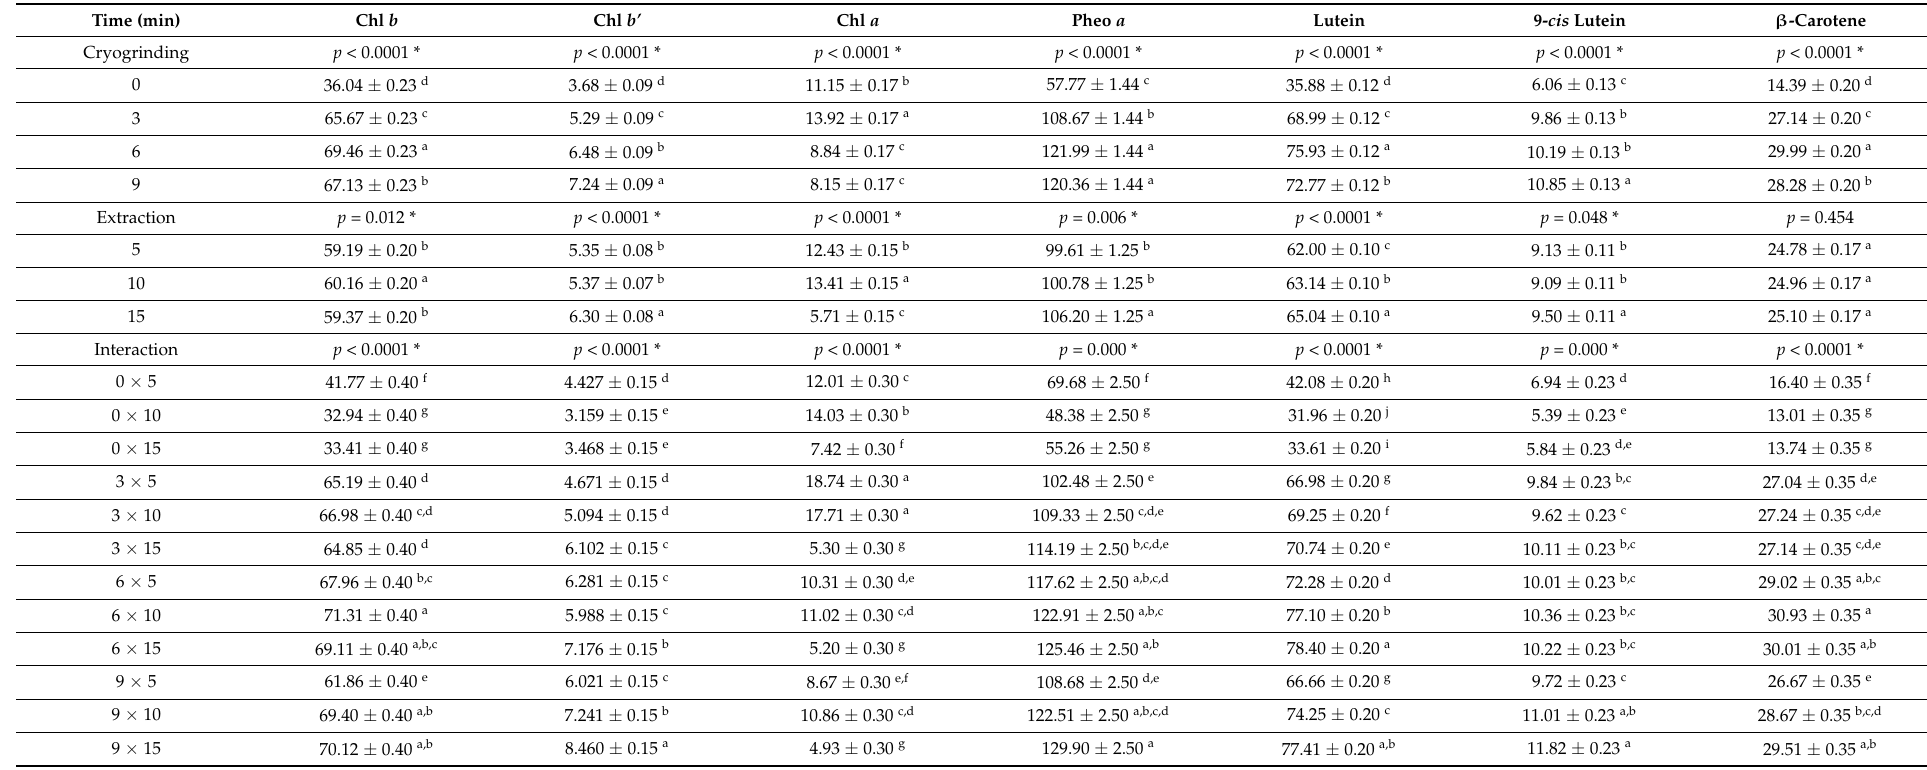
Table 3. Pigment profile (mg/100 g dw) of myrtle leaf extract obtained by different cryogrinding and extraction